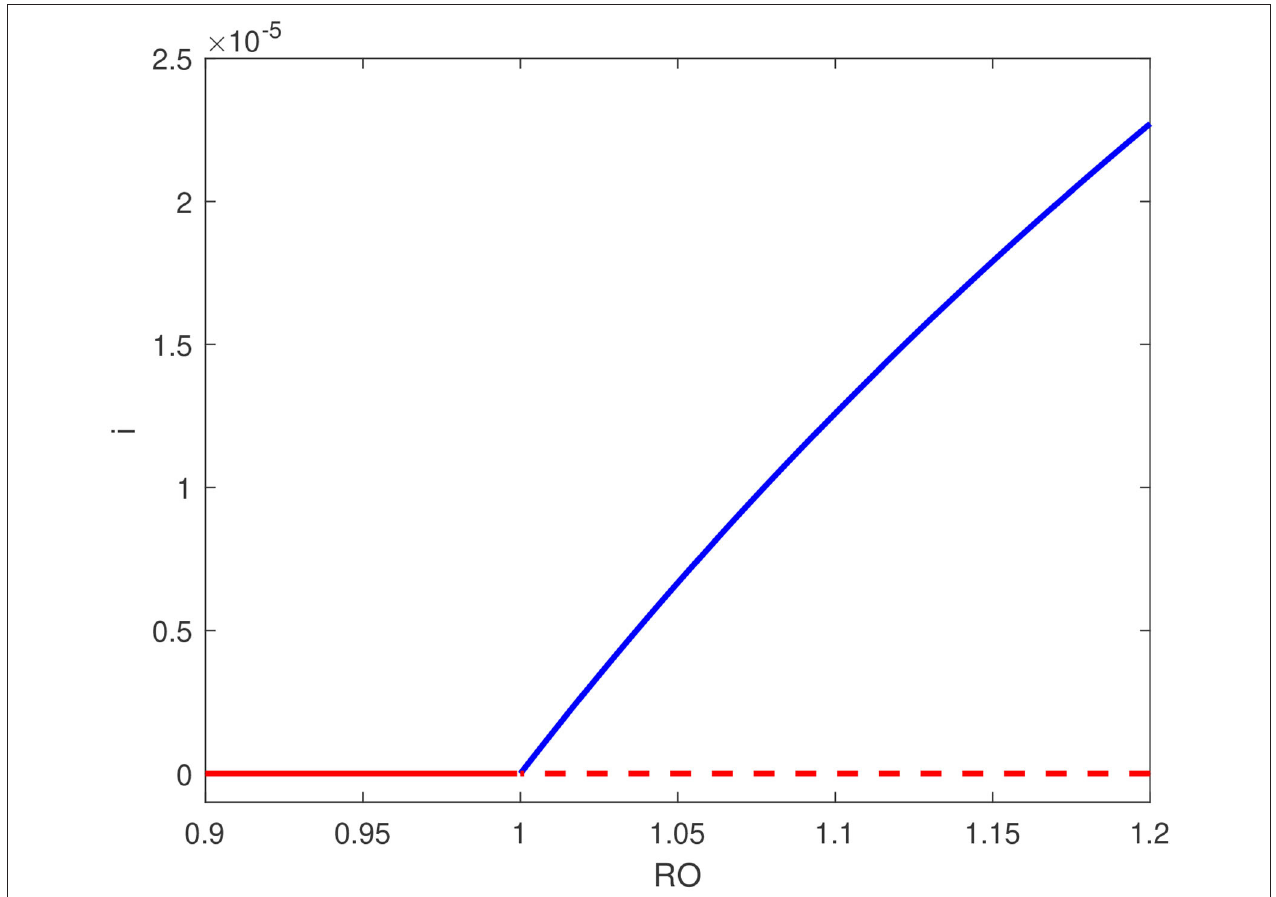
FIGURE 5 | Bifurcation diagram for b = 2.5 × 10 − 4 showing forward bifurcation; solid line (stable branch); dashed line (unstable branch); blue line (endemic equilibrium); red line (disease free equilibrium).